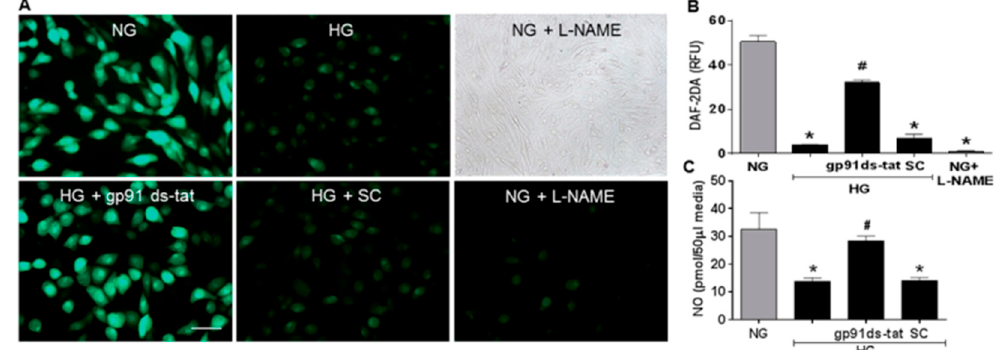
Figure 7. NOX2 blockade prevents high glucose-induced decreases in endothelial cell nitric oxide. Representative images ( A ) and quantitation ( B ) showing effects of NOX2 blockade on fluorescence for the NO indicator DAF-2DA in endothelial cells maintained in high glucose (HG) or normal glucose (NG) media. Quantitative analysis showed significant reduction of NO levels in samples from HG-treated cells as compared to NG controls. NO was preserved in HG cultures treated with the NOX2-blocking peptide gp91ds-tat but not in cultures treated with the scrambled control (SC) peptide. Treatment with the NOS inhibitor L-NAME significantly decreased NO in the NG cultures but did not alter cell density as shown by phase contrast image. * p < 0.0001 vs. NG, # p < 0.05 vs. HG, n = 6. Analysis of NO accumulation in the conditioned media (C) confirmed a decrease in NO release in the HG cultures that was blocked by gp91ds-tat, but not by the scrambled control (SC). * p < 0.05 vs. NG, # p < 0.05 vs. HG, n = 4–6. Scale bar = 20 µm.